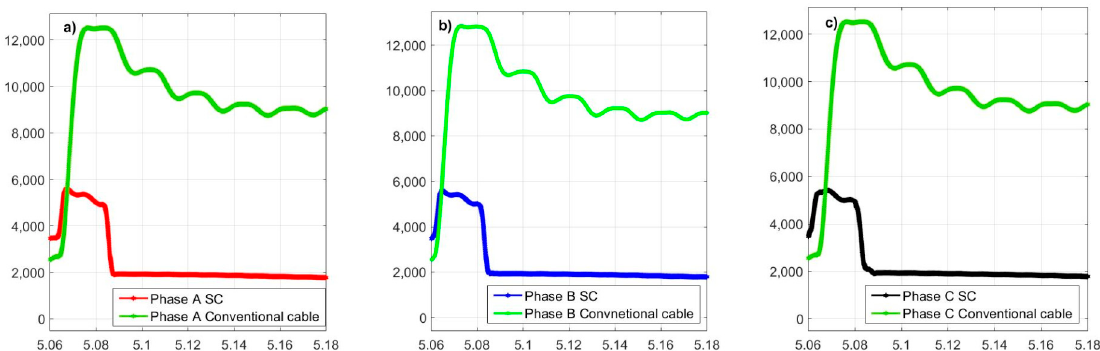
Figure 13. RMS values of the fault currents at Bus 11 during 3-Phase-to-ground solid fault at 50% of the proposed SCs and a conventional copper cable: ( a ) Phase A, ( b ) Phase B, ( c ) Phase C.